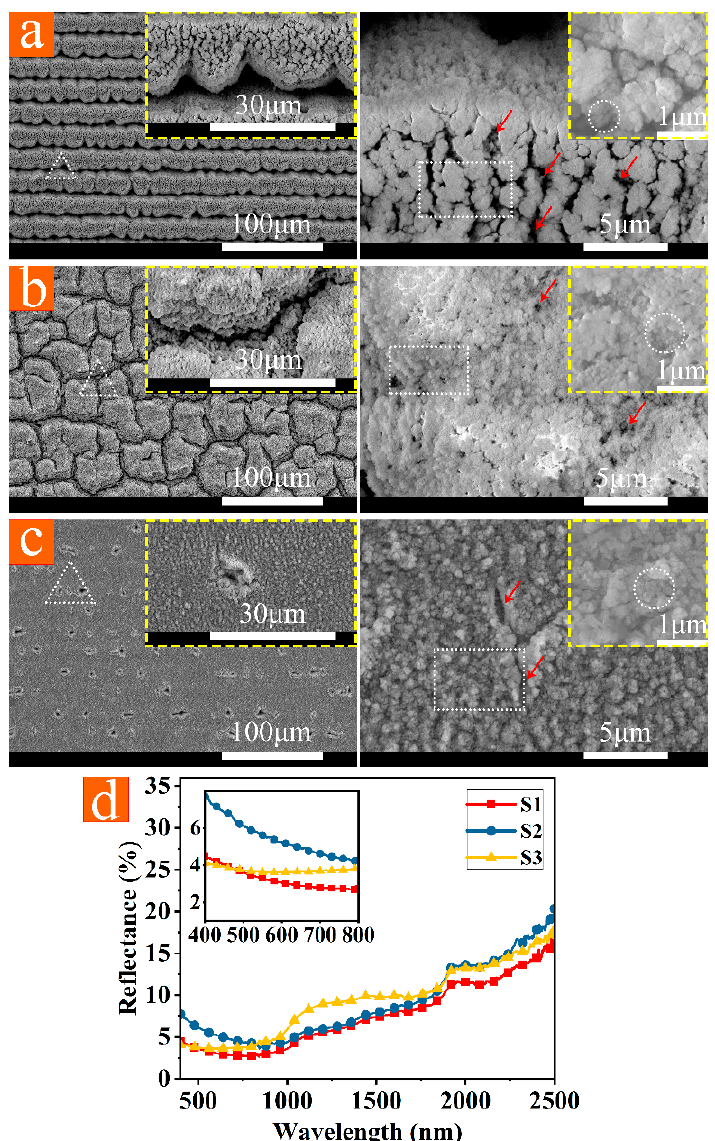
Figure 4. ( a – c ) SEM photographs (magnification of 1200 times, 5000 times, 20,000 times, and 100,000 times) of S1, S2, and S3. ( d ) Reflectance curves of S1–S3. Triangles (white), rectangles (white), and circles (white) represent, respectively, microscale light-trapping structures, subwavelength structures, and nanoparticles.